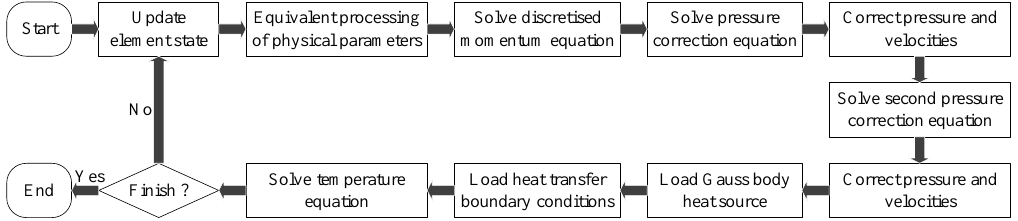
Figure 3. Calculation flow chart.